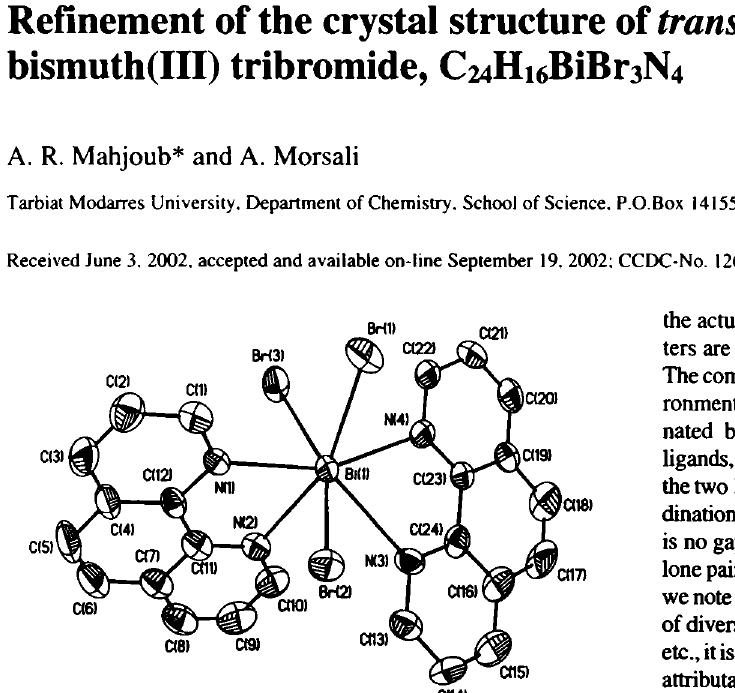
Table 2. Atomic coordinates and displacement parameters (in Â 2